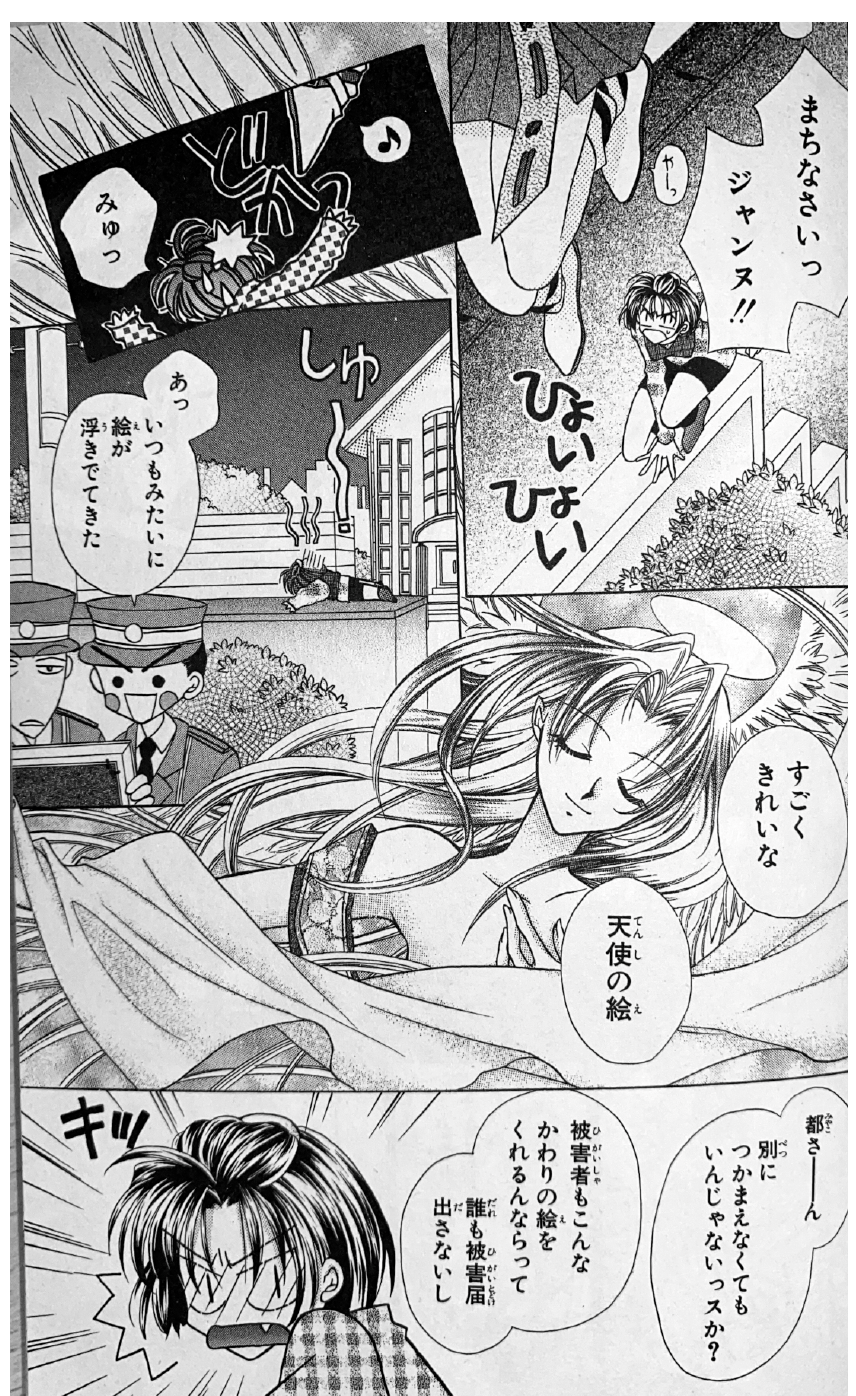
Figure 6 Image of an angel that appeared in a frame after Jeanne concealed a demon (complete page) (Tanemura